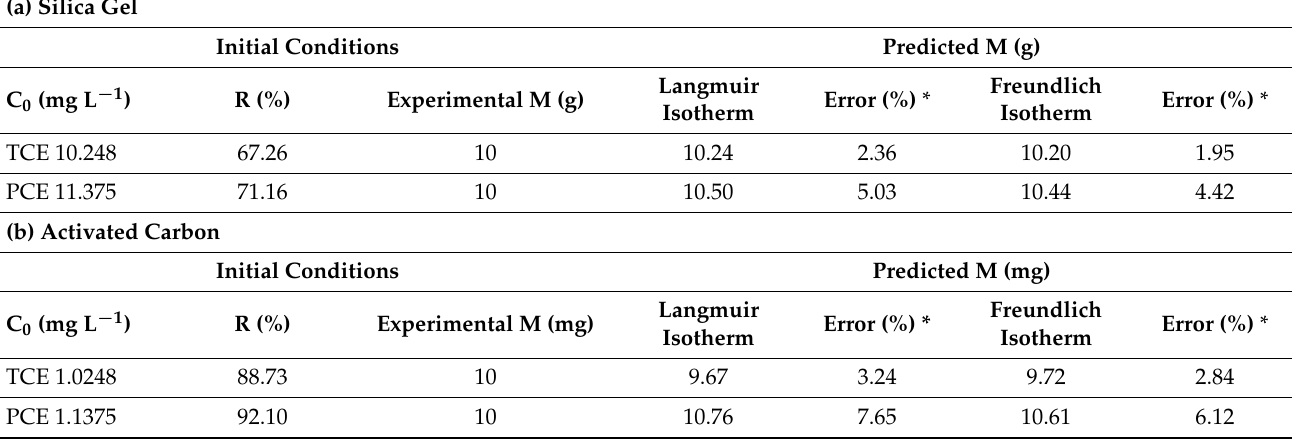
Table 11. Comparison of required adsorbent mass (M) predicted by Langmuir and Freundlich isotherms with mass balance to experimental data points obtained from the adsorption of TCE and PCE onto (a) silica gel and (b) activated